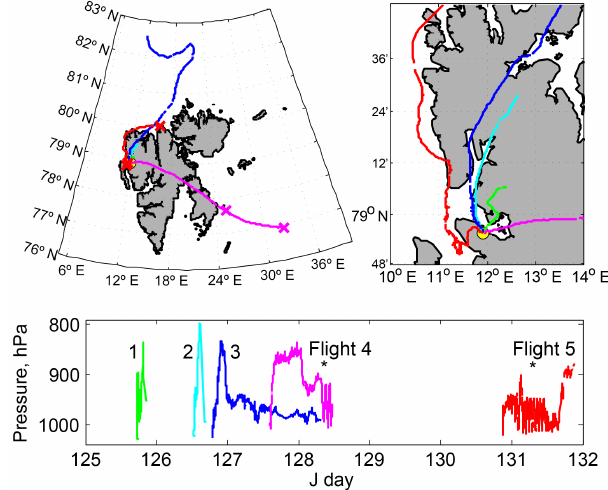
Figure 1. Trajectories of five CMET balloons launched from Ny- Ålesund in May 2011. Flight paths are shown on the regional scale of the island Spitsbergen, Svalbard and on the local scale of Kongs- fjord. Ny Ålesund is marked by a yellow circle and lies at the south- ern side of Kongsfjord. Balloons 4 and 5 performed repeated sound- ings as shown by the pressure variations in time (marked *). Anal- ysis periods for flights 4 (06:00–12:00UTC) and 5 (full flight) are denoted by